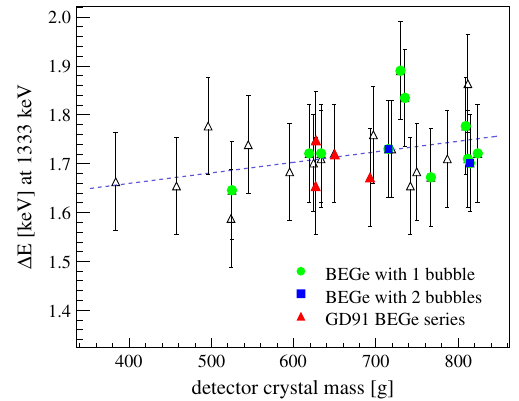
Fig. 7 Detector energy resolution dependence on the detector mass of all 30 Gerda Phase II BEGe detectors but GD02D. Open symbols are used as in Fig. 6